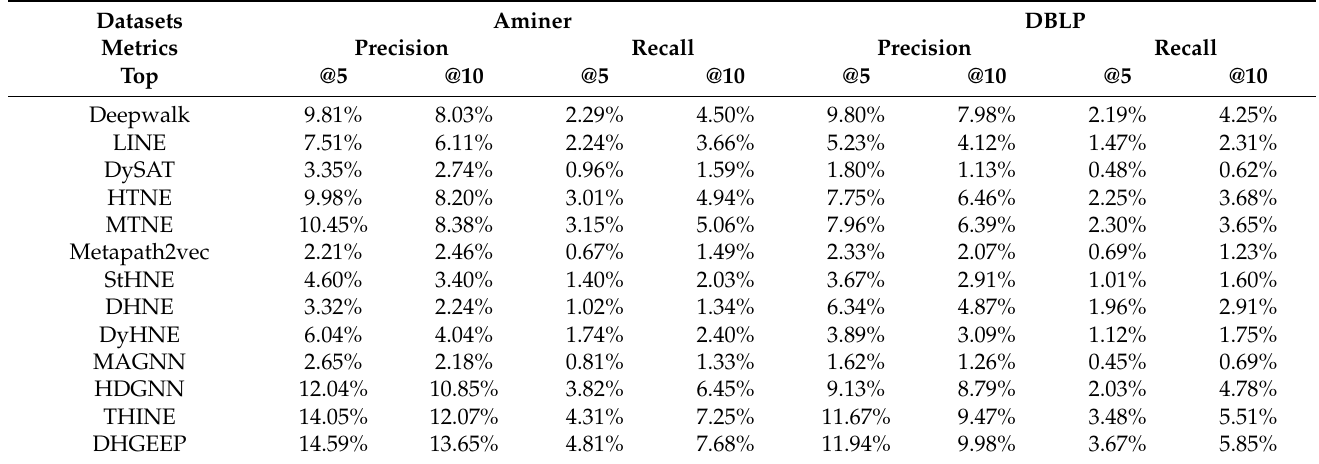
Table 3. Comparison of different algorithms in homogeneous-temporal-event prediction.